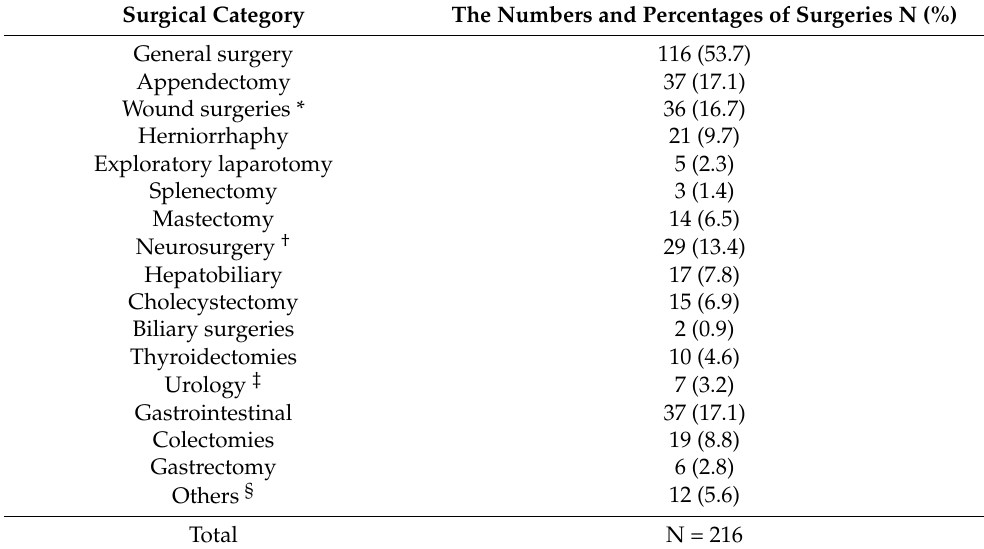
Table 2. The numbers and percentages of surgeries.